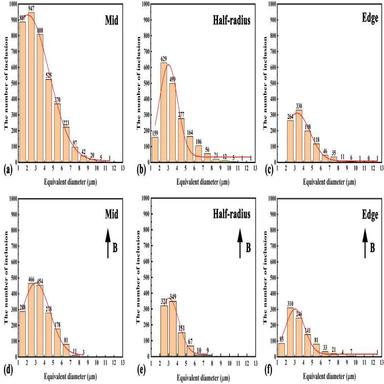
Statistical results on the number of inclusions (different size) in different regions of LMF (with or without ASMF) in this study, (a) Mid region without ASMF, (b) Half-radius region without ASMF, (c) Edge region without ASMF, (d) Mid region with ASMF, (e) Half-radius region with ASMF, (f) Edge region with ASMF, respectively